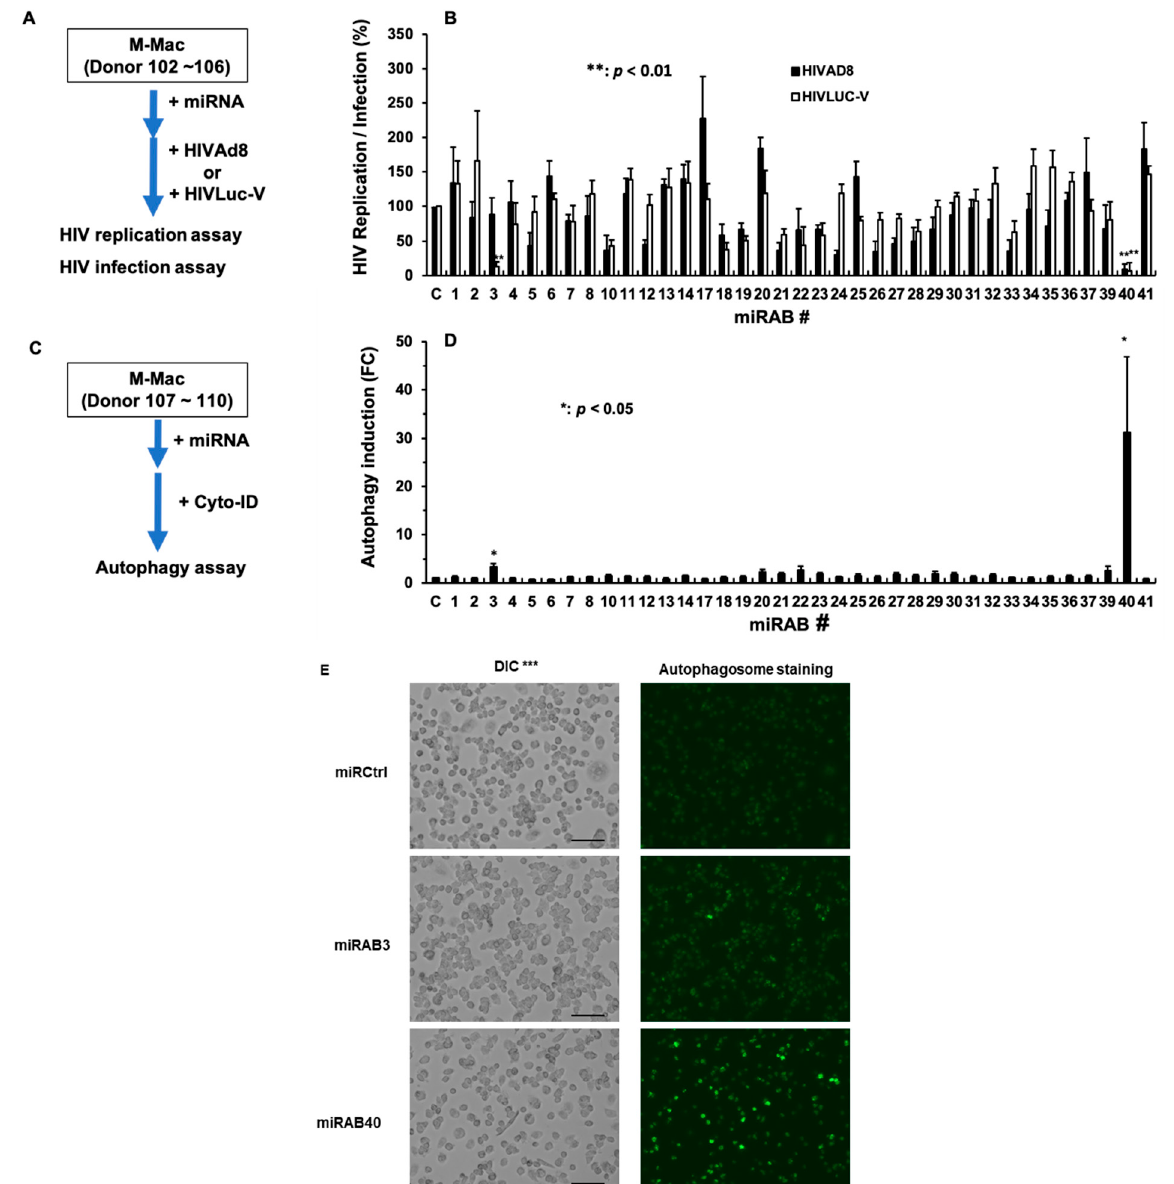
Figure 4. Evaluation of HIV-inhibiting and autophagy-inducing activities. M-Macs were transfected with final 10 nM of chemically synthesized novel miRNA mimics and then cultured for three days at 37 ° C. ( A ) Diagrams depict protocol of HIV assay. The miRNA-transfected M-Mac from five independent donors (Donor 102~106) were infected with HIVAD8 or HIVLuc-V virus, and then cultured for 14 days for HIVAD8-infected cells and for 48 h for HIVLuc-V-infected cells as described in the Materials and Methods. ( B ) HIV replication in culture supernatants was monitored with an HIV antigen capture ELISA kit, and HIV infection was determined using cell lysate of the infected cells with the Bright-Glo Luciferase kit. All experiments were performed quadruplicate. Data indicate relative amounts of HIV replication activity in each miRAB-transfected cell compared to that in miRCtrl-transfected cell by means ± SE. ( C ) Diagrams depict protocol of autophagy assay. To detect autophagy induction, autophagosomes in the miRNA-transfected cells from four independent donors (Donor 107~110) were stained as described in the Materials and Methods. ( D ) Each assay was conducted duplicate. Data indicate relative amounts of autophagy activity in each miRAB-transfected cell compared to that in miRCtrl [C]-transfected cell by mean of fold change (FC) ± SE. ( E ) An autophagosome staining image of M-Mac (Donor 107) transfected with either miRCtrl, miRAB3, or miRAB40. Images were taken at 10× magnification using a Zeiss Axio Observer.Z1 motorized microscope (Carl Zeiss Microscopy), as described in the Materials and Methods, and used for quantification of autophagy induction. *, and ** indicate p values are < 0.05 and < 0.01, respectively. Scale bars show 100 μ m.